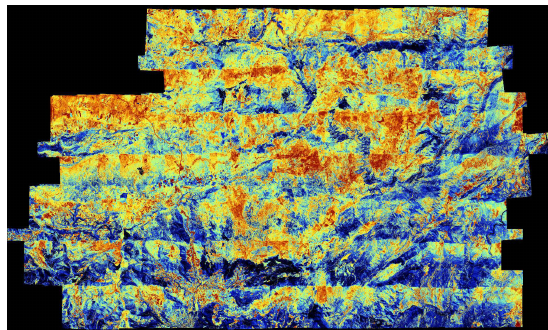
Figure 9a: Orthophotomosaic with uncorrected overlaps